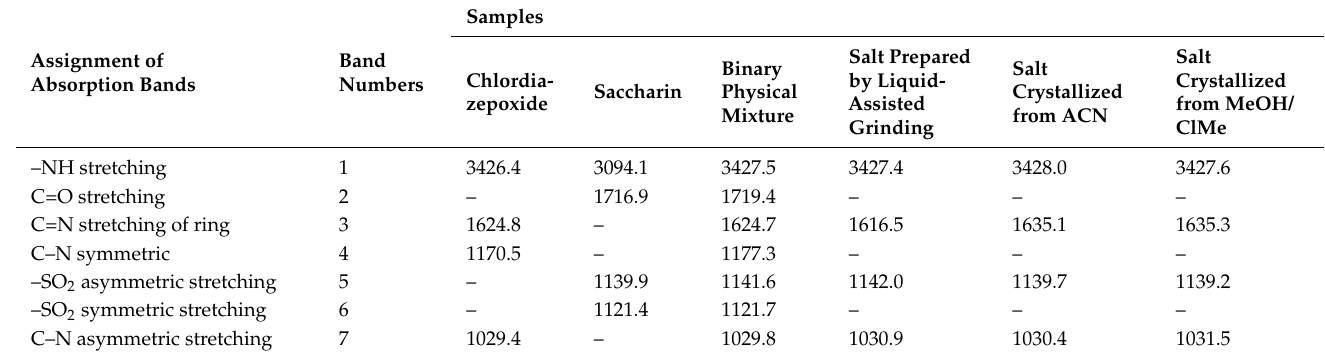
Table 6. Characteristic absorption bands acquired from the FT-IR spectra for chlordiazepoxide, saccharin, chlordiazepoxide mixture with saccharin, and saccharin salts of chlordiazepoxide prepared by different